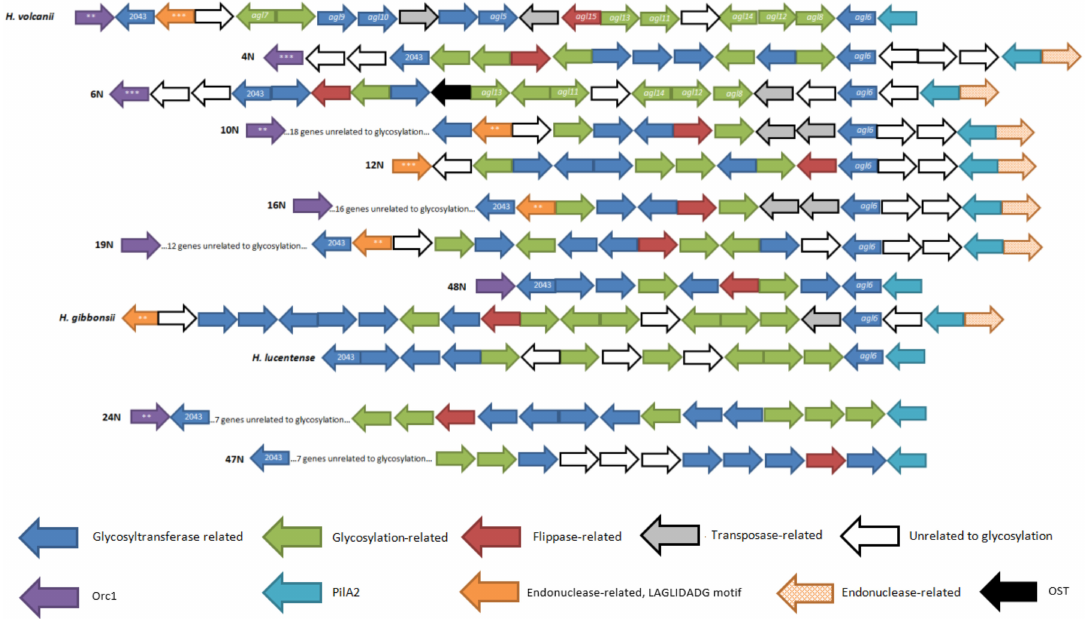
Figure 5. Schematic presentation of the agl6 -based glycosylation gene clusters in four different Haloferax strains and the nine Haloferax isolates. The sizes of the genes are arbitrary. Asterisks indicate homology. Glycotransferases marked 2043 are homologs to HVO_2043, which is an uncharacterized gene adjacent to the alternative glycosylation gene pathway in H. volcanii . The legend describes the function assigned to each color used in the scheme. Protein function prediction was performed using HHpred